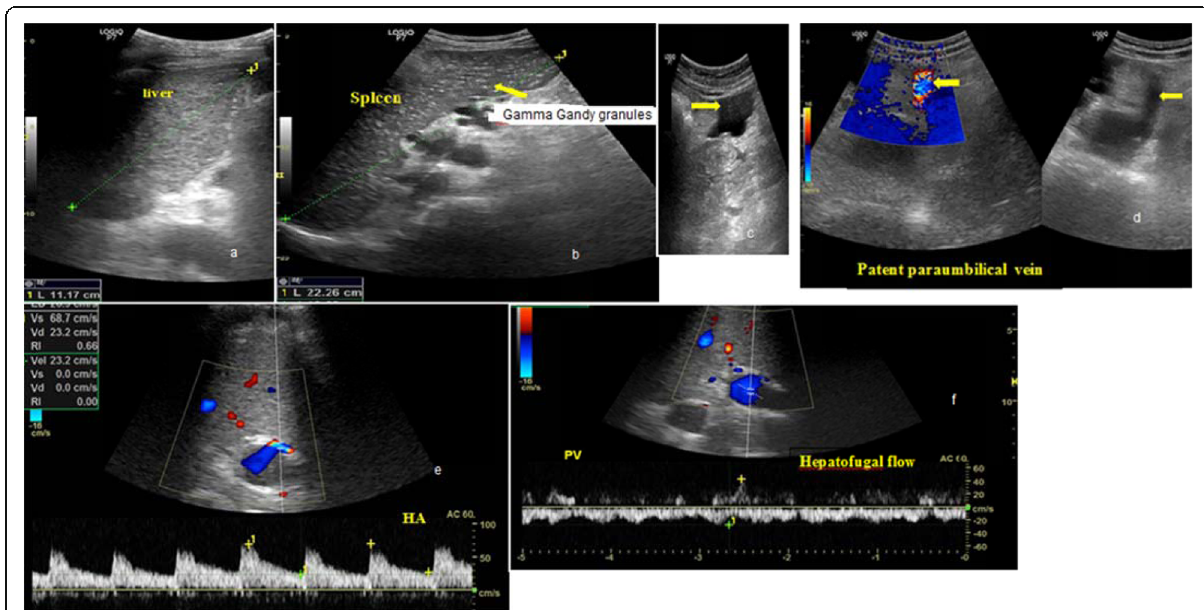
Fig. 4 US images ( a – f ). a – c Grayscale images showing a cirrhotic liver ( a ) splenomegaly ( b ) (length = 22 cm) with a myriad of echogenic non- shadowing foci representing Gamma-Gandy nodules (yellow arrow)(an association with longstanding portal hypertension). c Mild amount of free ascites was noted (yellow arrow). d Color Doppler and grayscale images showing recanalized para-umbilical vein (yellow arrows). e Spectral Doppler image tracing the main portal vein at the porta hepatis showing a reversed hepatofugal (away from the liver) flow. f Spectral Doppler image tracing the HAV and HARI, where the HAV is elevated = 68.7 cm/s, and HARI was normal =